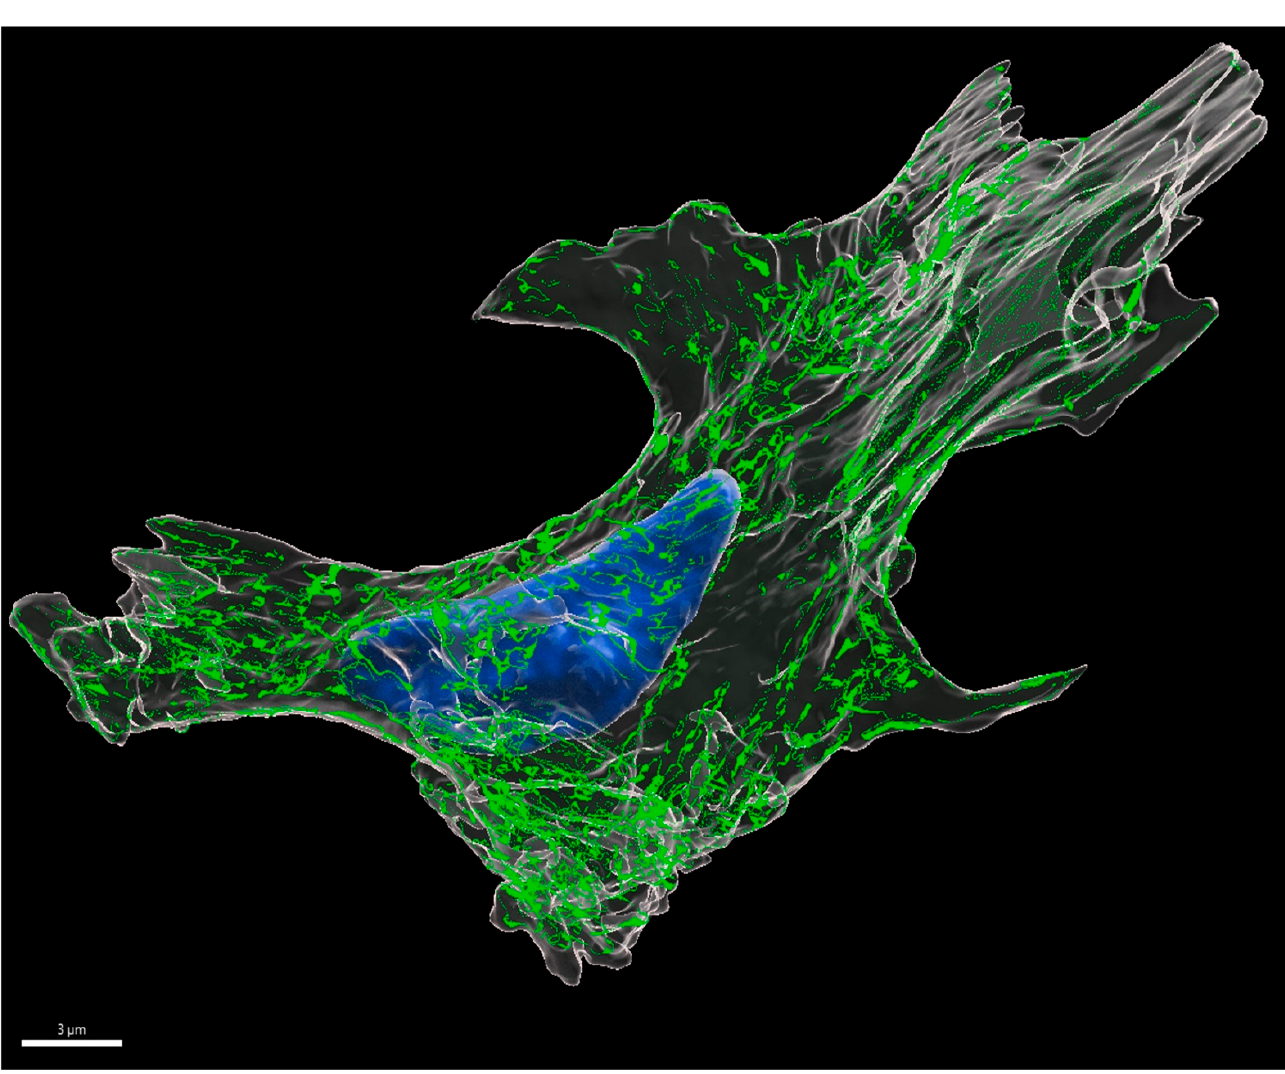
Figure 3. Presentation of a whole 3D-reconstructed myofibroblast in the maternal stroma of a pregnant cow (278 gd). The cell demonstrates processes in varying length and size, stress fibers (green) located in the cell periphery and the nucleus (blue), surrounded by the cytoplasm and cell membrane (white). Scale bar = 3 µm.